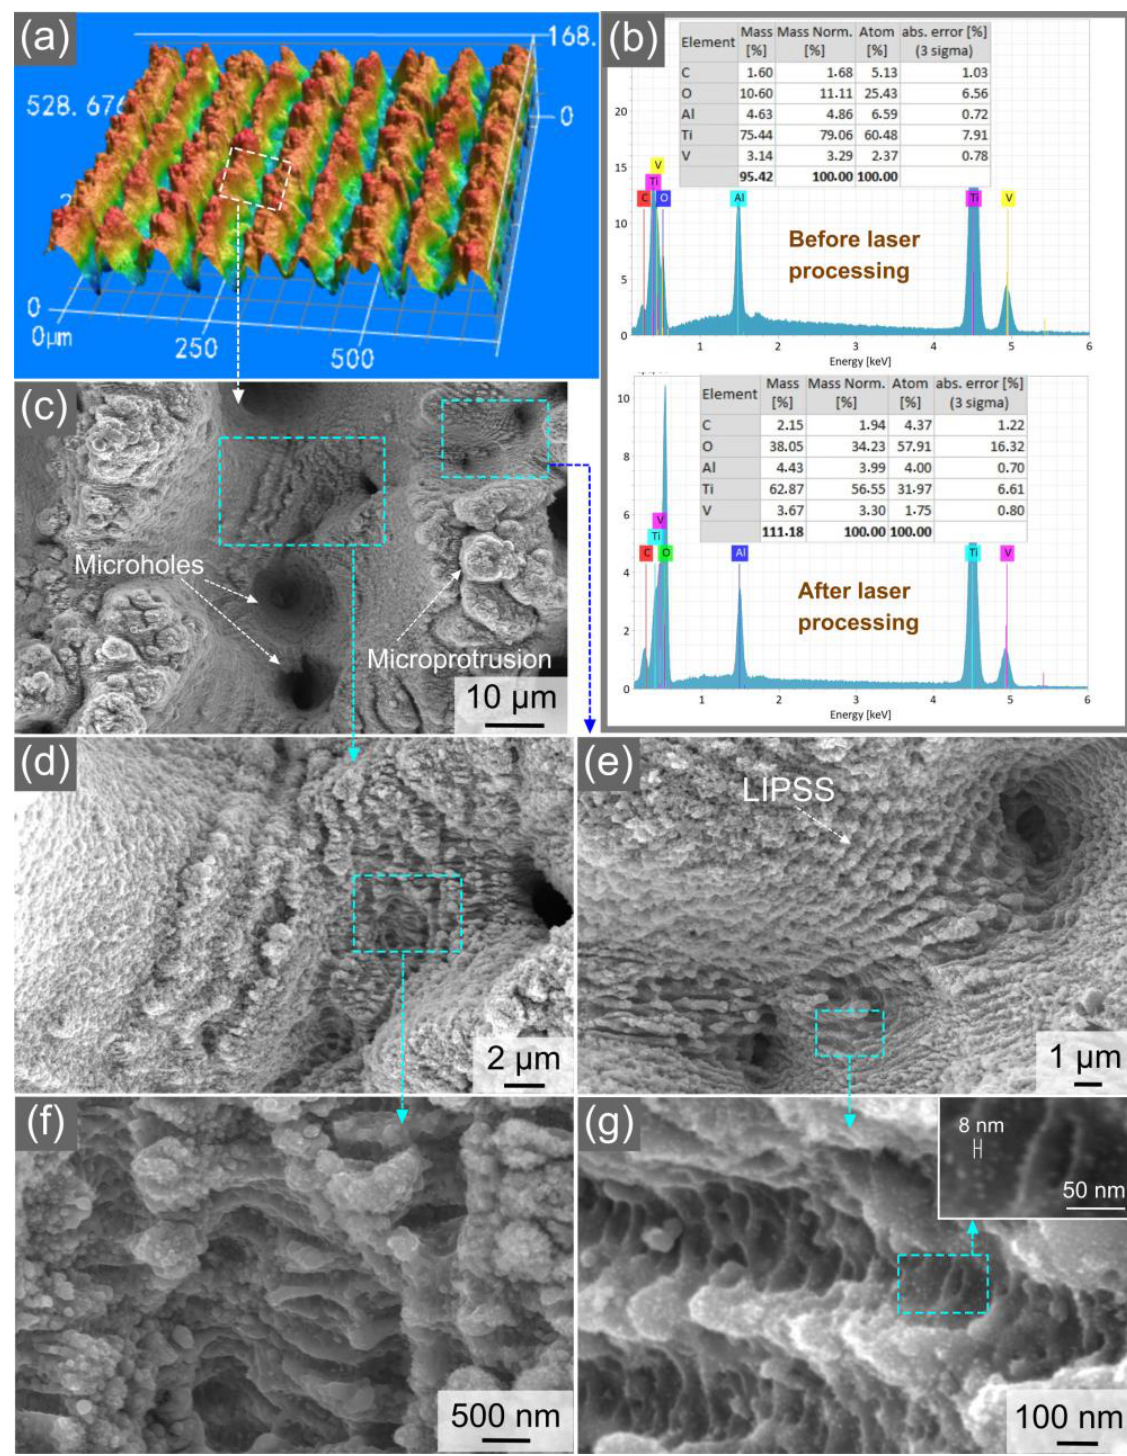
Figure 3. ( a ) 3D optical image of the array of parallel microgrooves on the sample surface. ( b ) Elemental composition of the sample surface before and after femtosecond laser processing. ( c ) SEM image of a microgroove. ( d ) Microstructural features on the bottom of the microgroove. ( e ) LIPSS-textured area on the microgroove ridge. ( f ) Nanostructures on the microgroove bottom. ( g ) Nanostructures on the microgroove ridge.